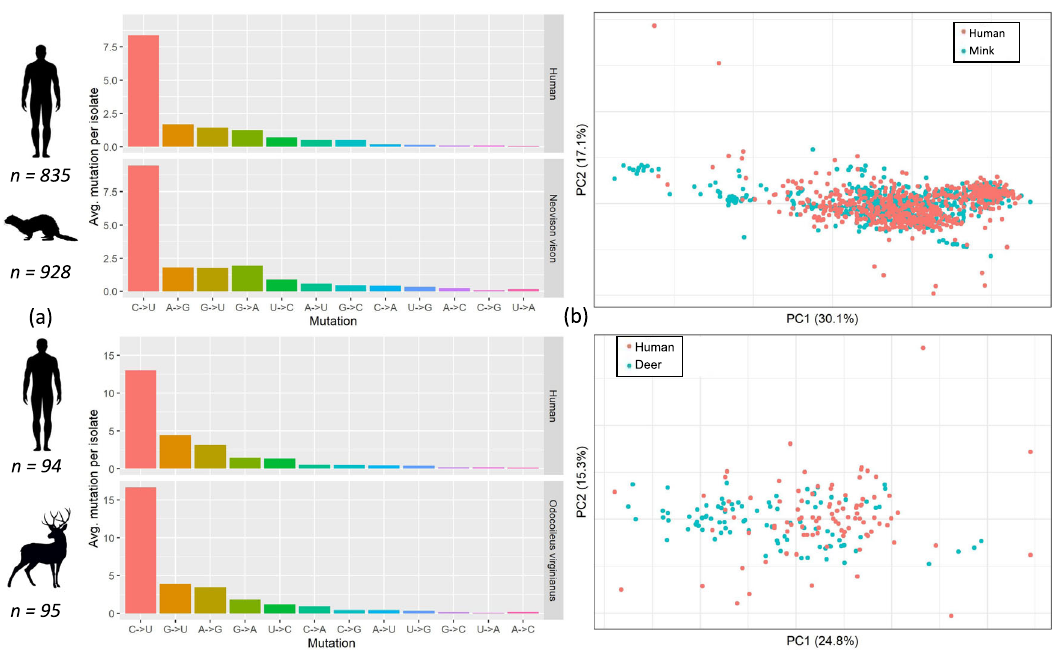
Fig. 4 Host-speci fi c genomic landscapes. a Nucleotide-nucleotide transition frequencies (x-axis) against average mutations observed per isolate in human and animal hosts (as indicated by symbols), and b principal components analysis of all dinucleotide frequencies, strati fi ed by